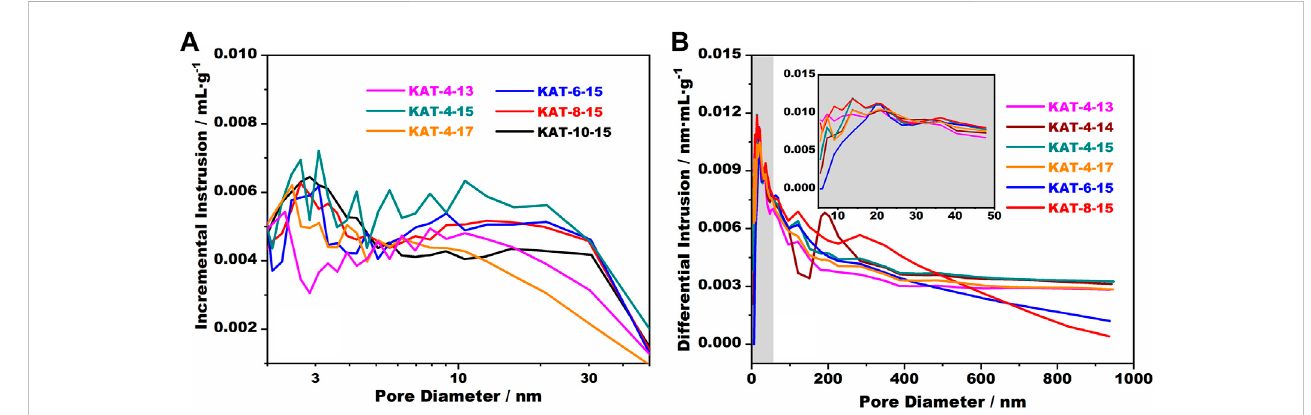
FIGURE 4 Pore size details of the resultant aerogel tapes given by the methods of (A) N 2 adsorption and (B)